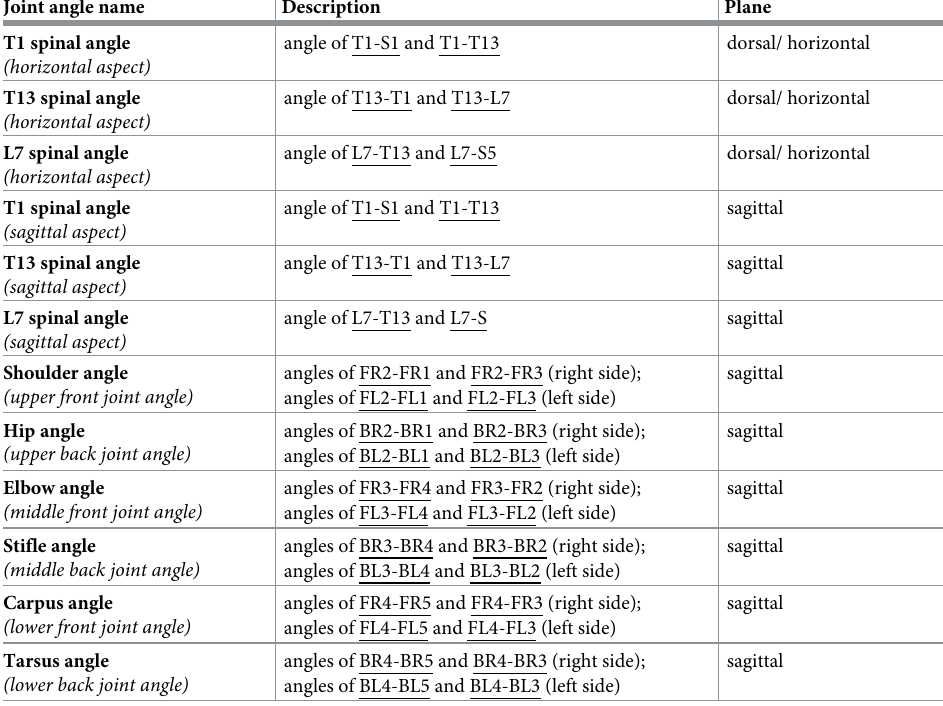
Table 2. Description of the calculated joint angles.